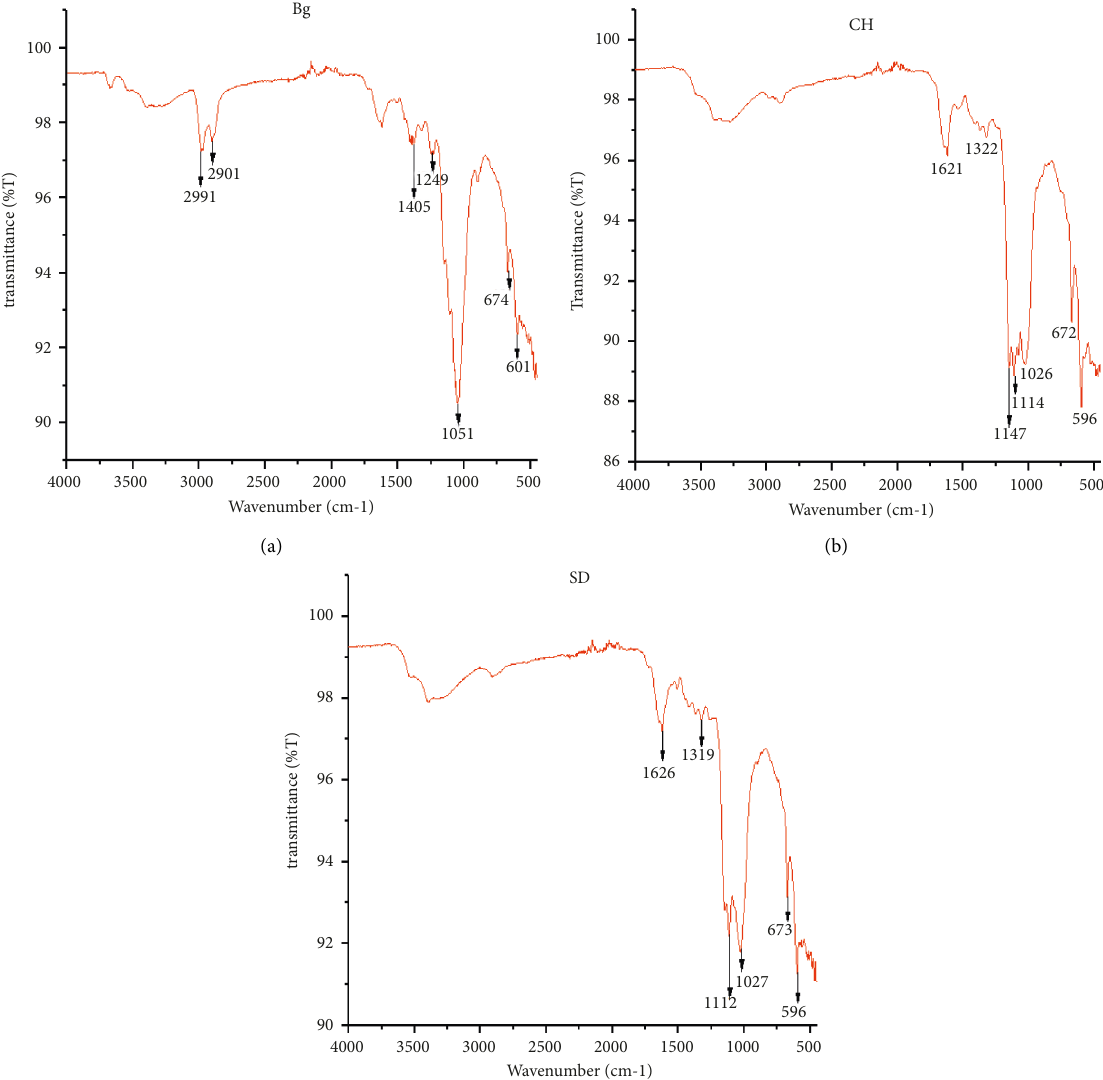
Figure 7: FT-IR spectra band grown on different substrates (a) Bg, (b) CH, and (c)